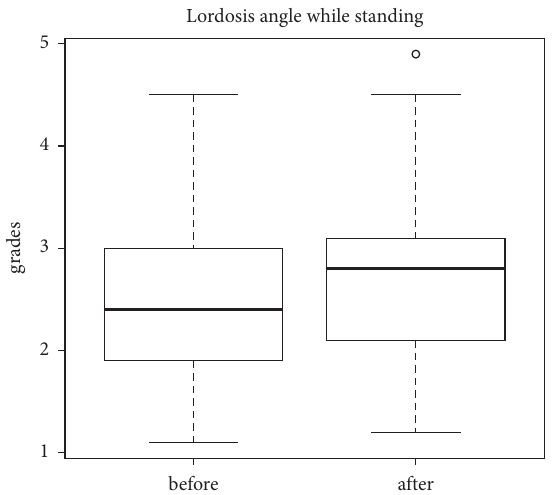
Figure 11: Distribution of the pelvic range of motion relative to the lumbar region (anterior-posterior tilt of the iliac alae) during walking.